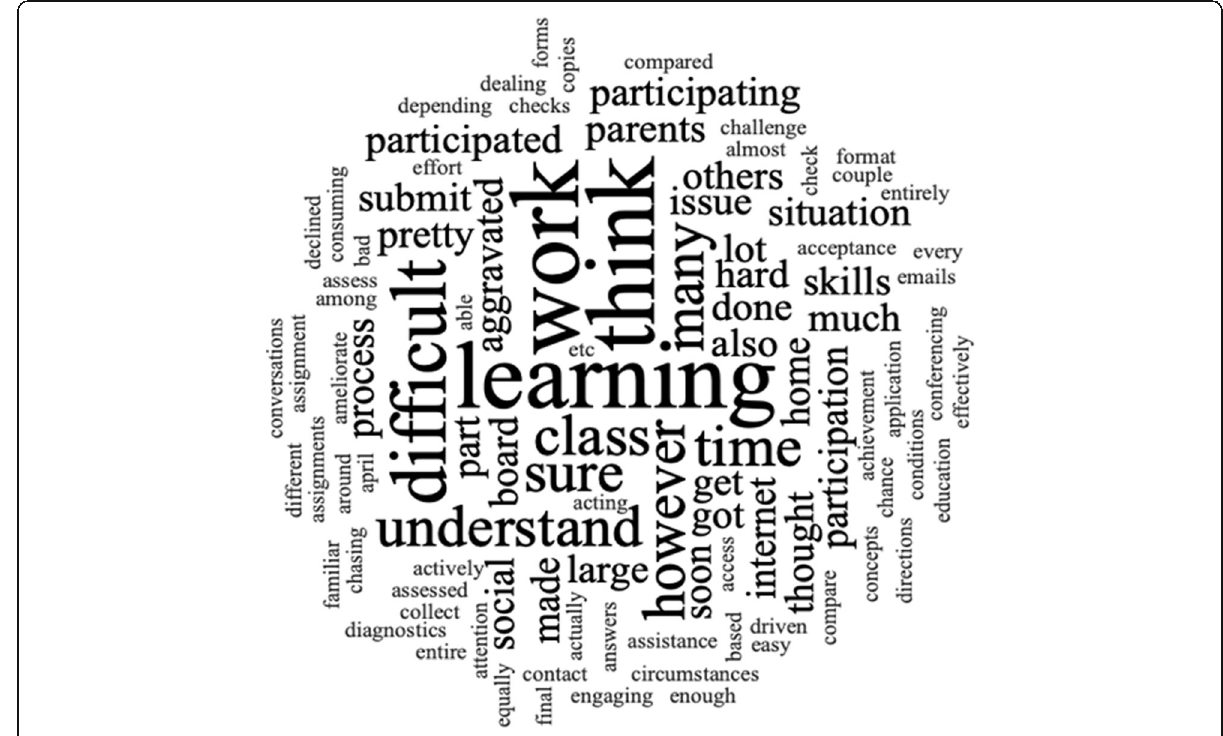
Fig. 2 A sample word cloud generated in NVivo